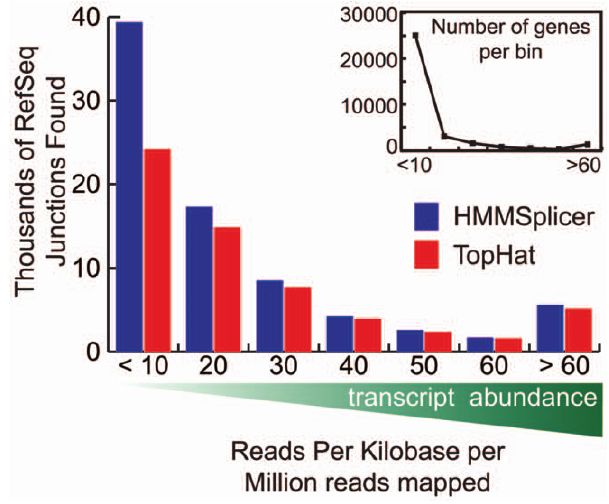
Figure 5. Human results compared by transcript abundance. Transcript abundance was measured as Reads Per Kilobase per Million reads mapped (RPKM) and the genes were binned by RPKM to show the number of RefSeq junctions found at different levels of transcript abundance. For genes with an RPKM less than 10, HMMSplicer found 76.2% more junctions, whereas for genes with an RPKM above 50, HMMSplicer found only 6.7% more junctions. While a smaller number of highly expressed genes dominate the mRNA population, 74.8% of genes have RPKM values less than 10.